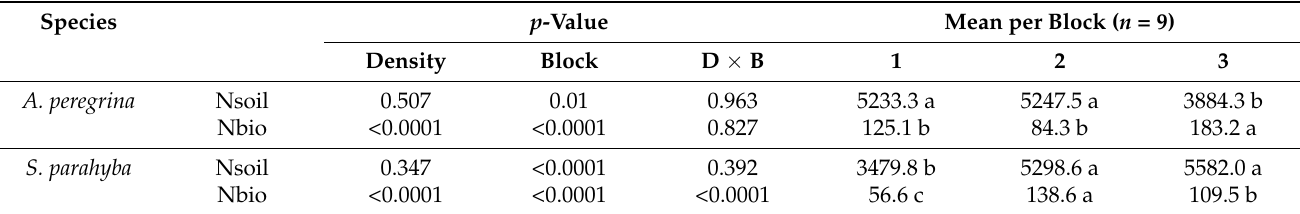
Table 2. Effect of stand density (D, trees ha − 1 ), block (B), and interaction (D × B) on the soil N pools (Nsoil, kg ha − 1 ) and the N content of the aboveground biomass (Nbio, kg ha − 1 ) in monospecific stands of A. peregrina and S. parahyba . For a given species and N pool, different letters indicate statistical differences between blocks.Significant differences in the mean values are indicated by different